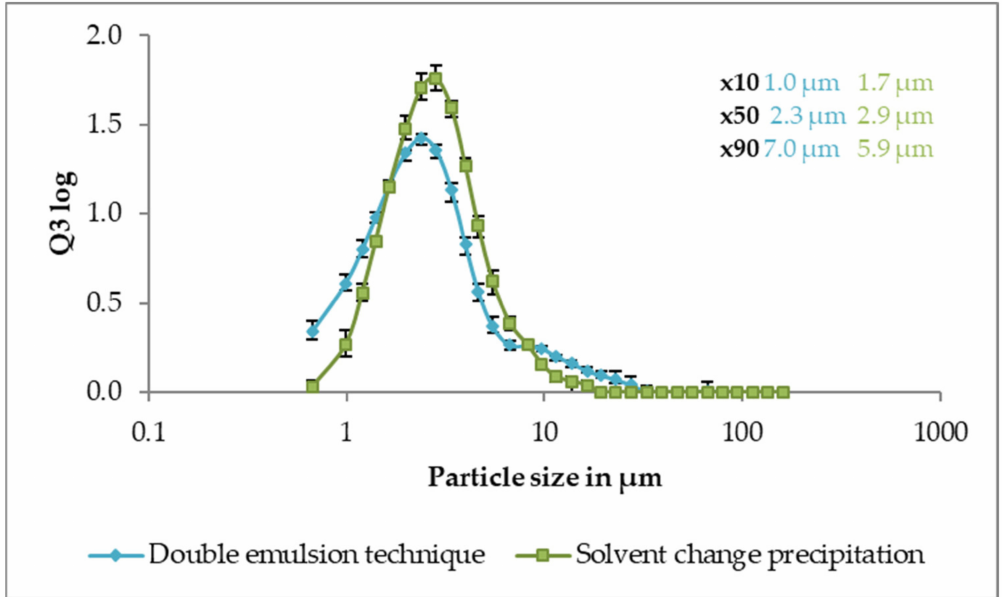
Figure 4. Particle size distribution of spray dried powders with nanoparticles prepared via solvent change precipitation (green) or double emulsion technique (blue) as measured by laser diffraction (3 bar pressurised air dispersion). Data is average of n = 7, error bars show min–max.